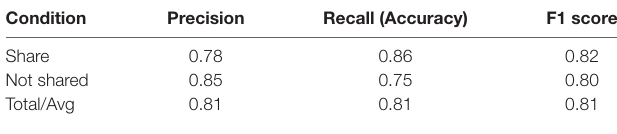
TABLE 2 | Classification results using pleasantness ratings (self-reported variable) plus EEG